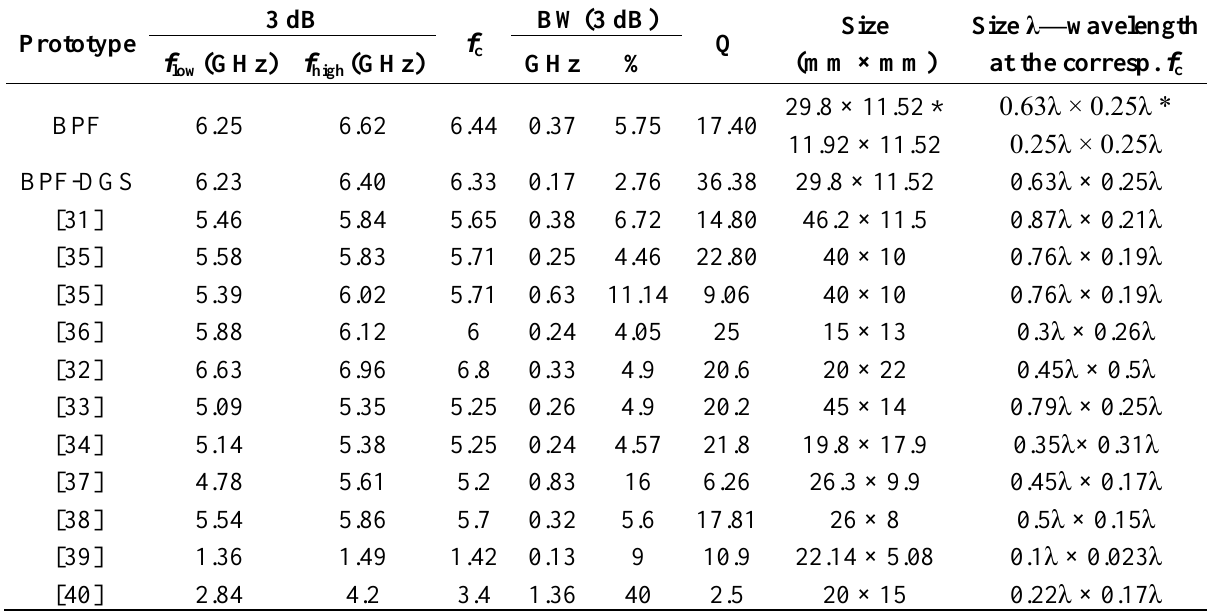
Table 2. Comparison with other band-pass